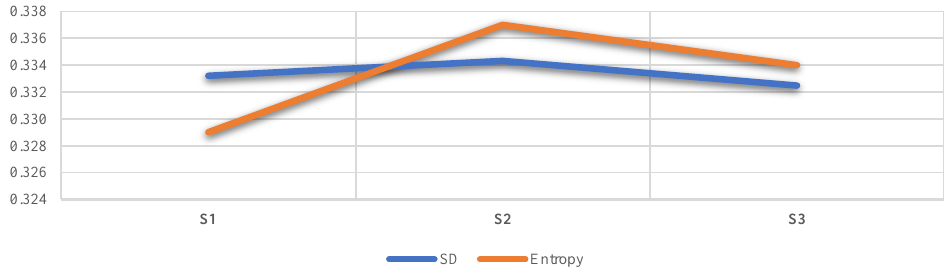
Figure 7. The comparison of SD and entropy in the case of stability computation: the second suppliers’ evaluation example.